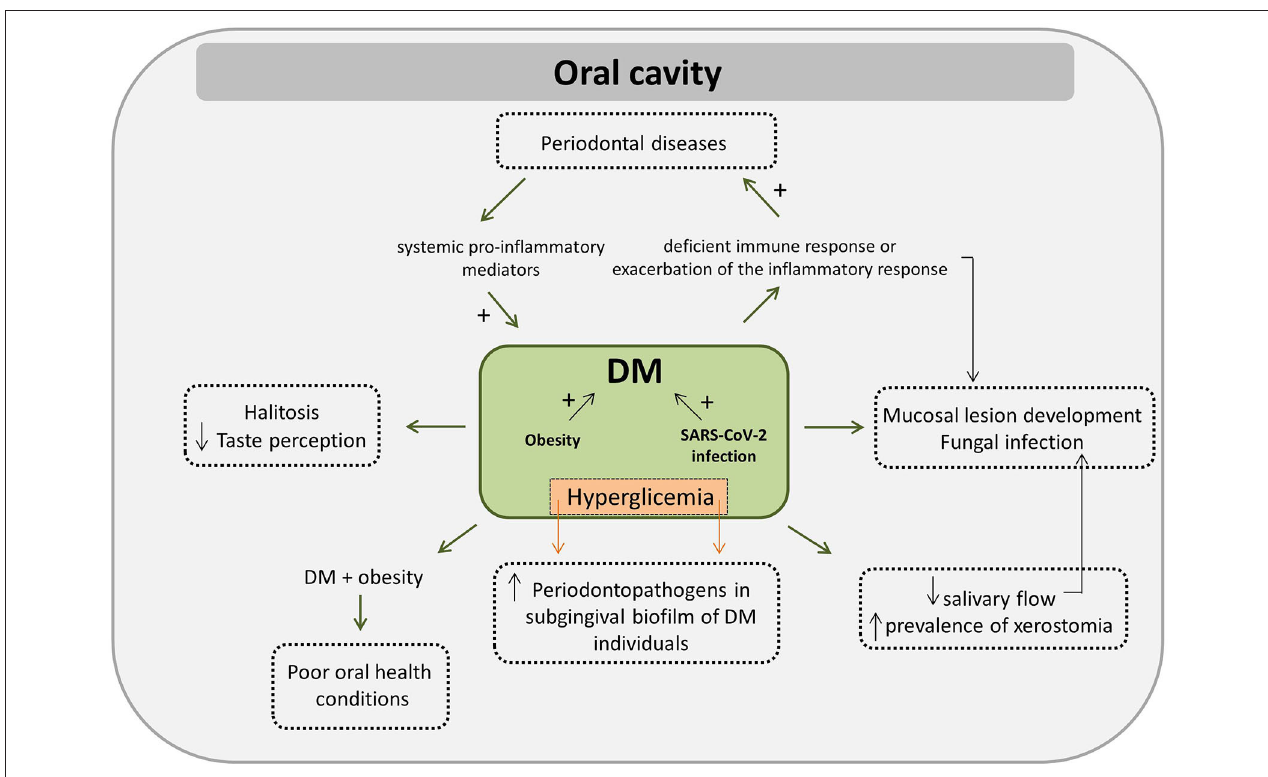
FIGURE 1 | Interplay among oral cavity conditions, host immune response, DM and some of its risk factors. DM, Diabetes mellitus, “ + ” means aggravating